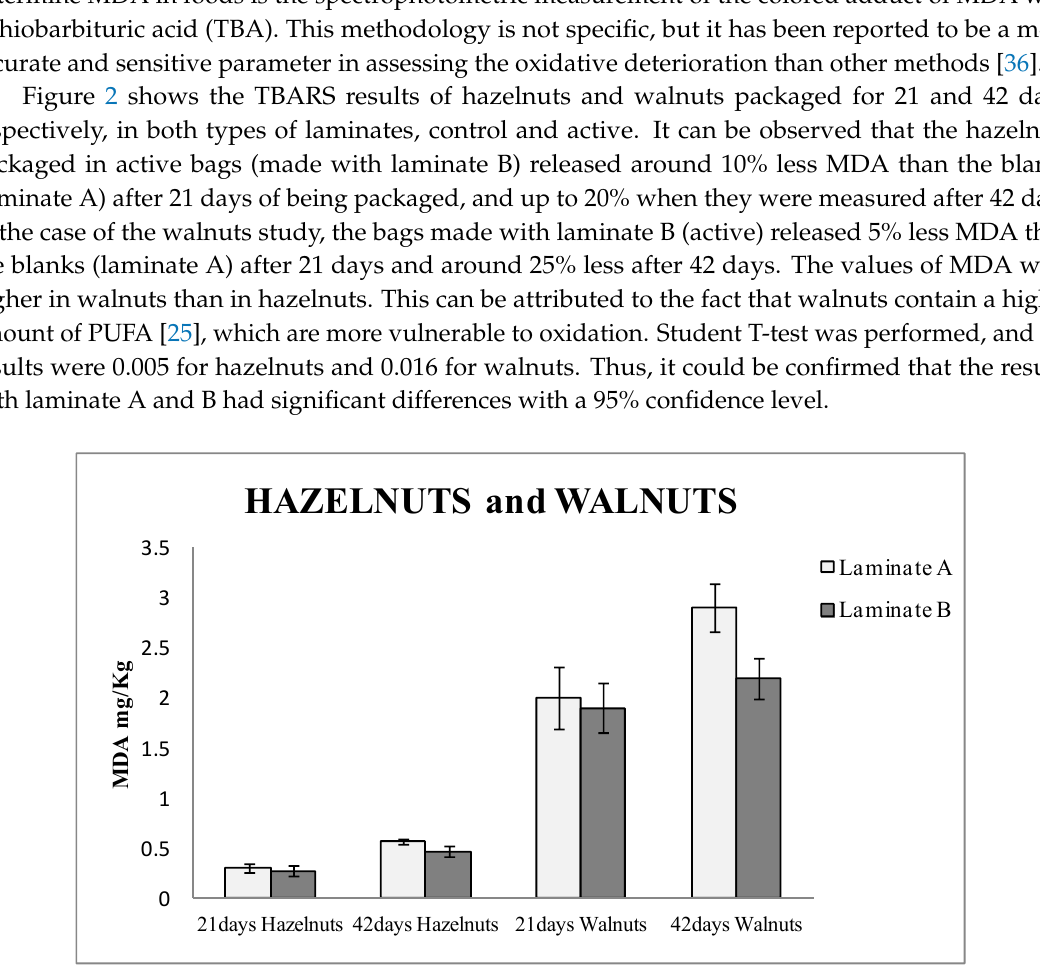
Figure 2. Thiobarbituric acid reactive substances (TBARS) results expressed as mg of malonaldehyde (MDA) per kg of hazelnuts and walnuts packaged in laminate A (control) and laminate B (actives with nanoselenium particles) for 21 and 41 days, respectively.